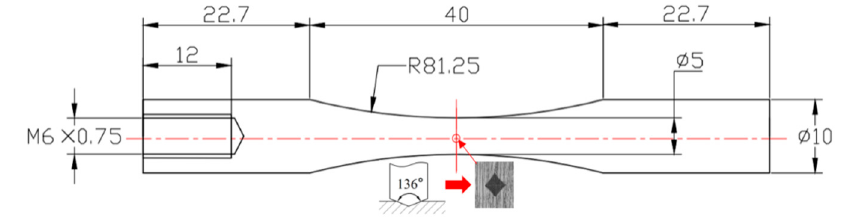
Figure 1. A schematic drawing of the ultrasonic fatigue specimen (dimensions in mm).